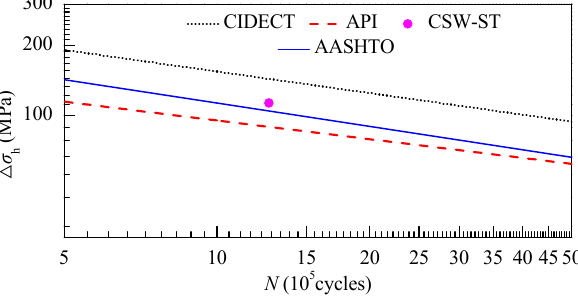
Figure 15. Comparison of the existing S - N curves.